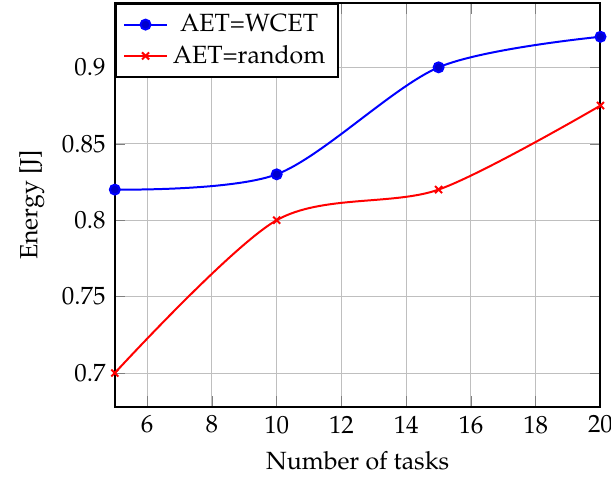
Figure 10. Influence of the AET and Task Number on